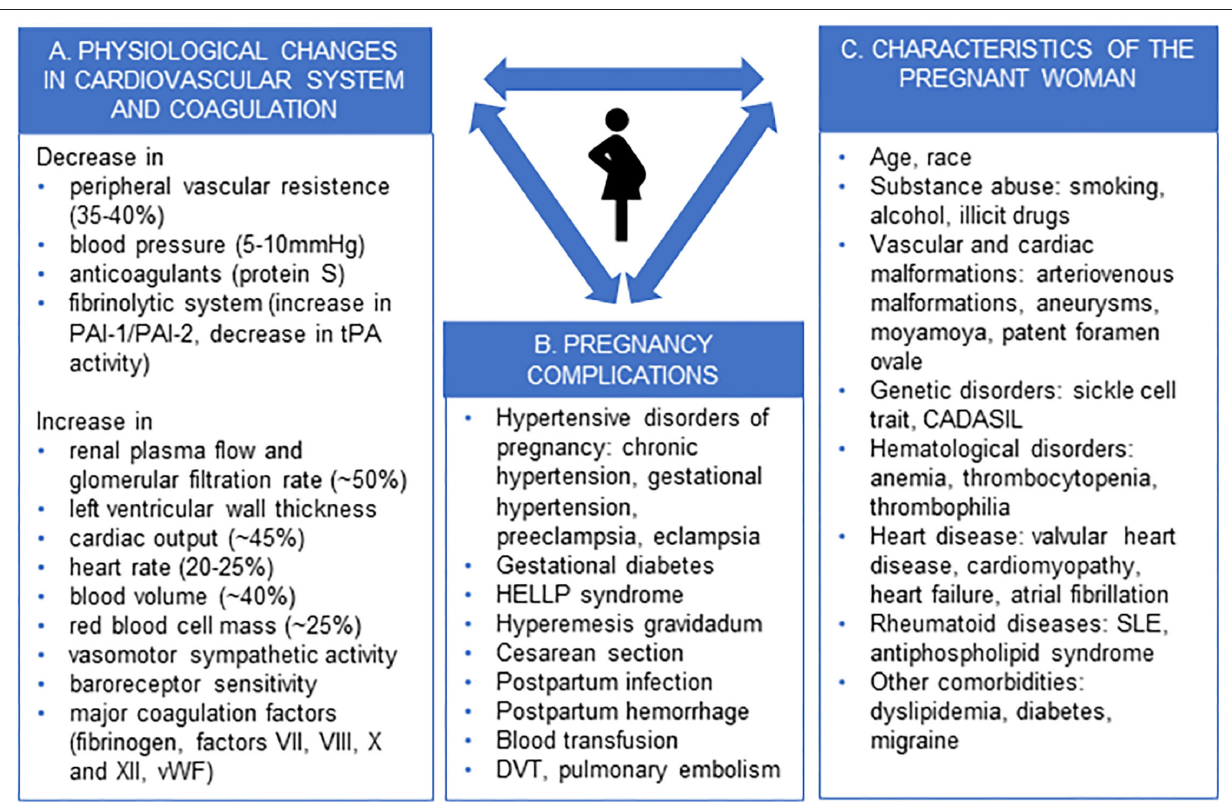
FIGURE 1 | Physiological changes in pregnancy (A) , pregnancy complications (B) , and characteristics of the pregnant woman (C) predisposing to stroke. PAI-1, plasminogen activator inhibitor-1; PAI-2, plasminogen activator inhibitor-2, tPA, tissue plasminogen activator; vWF, von Willebrand factor; HELLP, haemolysis, elevated liver enzymes and low platelets, DVT, deep venous thrombosis, CADASIL, cerebral autosomal dominant arteriopathy with subcortical infarcts and leukoencephalopathy, SLE, systemic lupus